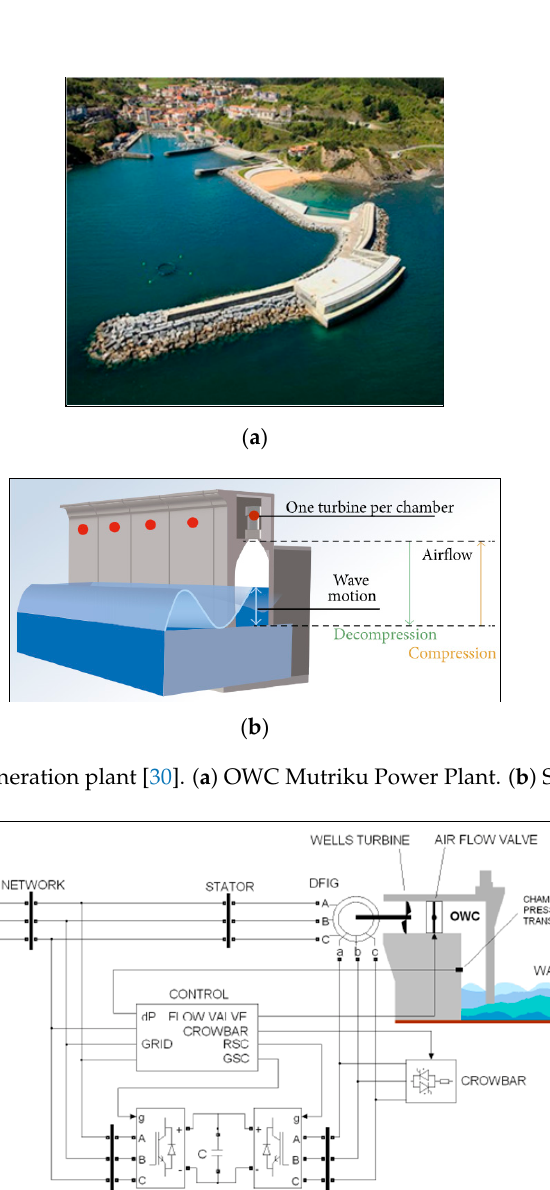
Figure 7. General scheme of Mutriku OWC system [29].